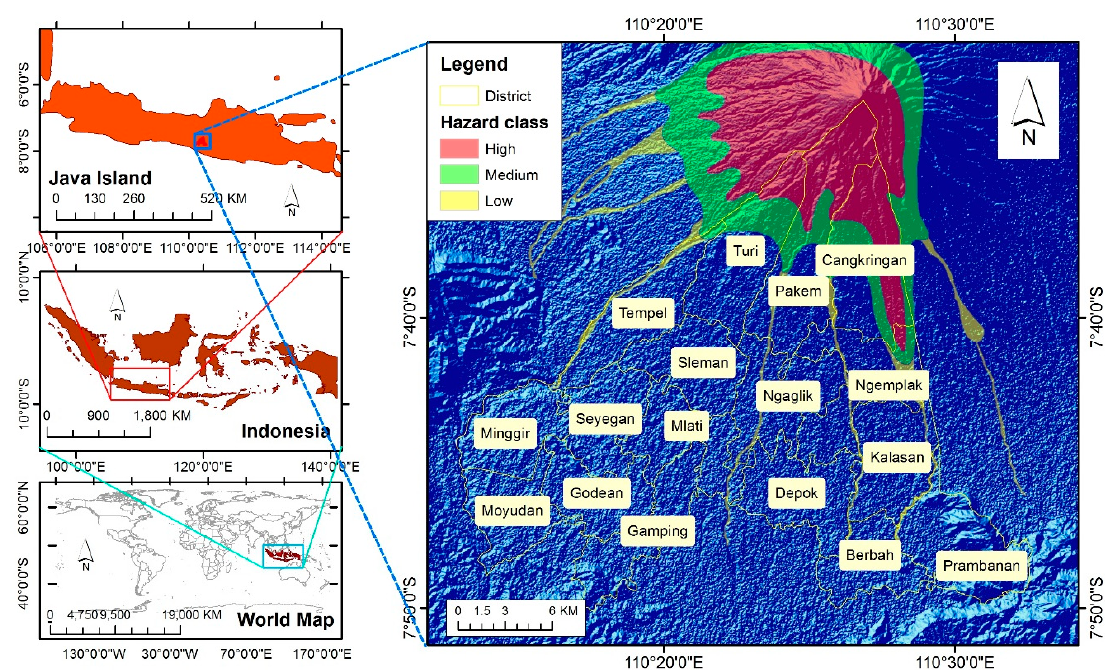
Figure 2. The hazard zones of Merapi volcano and the Sleman area.